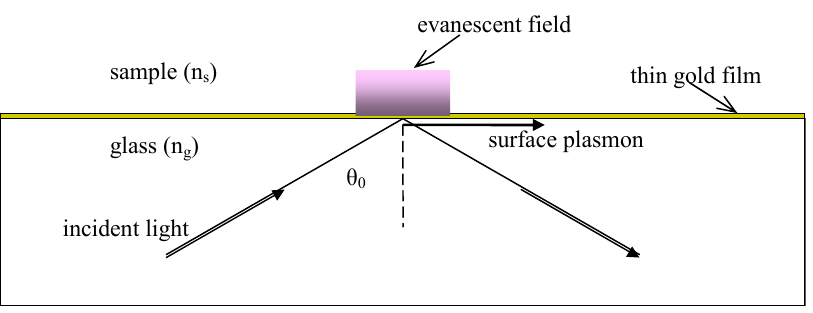
Figure 1. Basic setup for the excitation of surface plasmons by means of a light